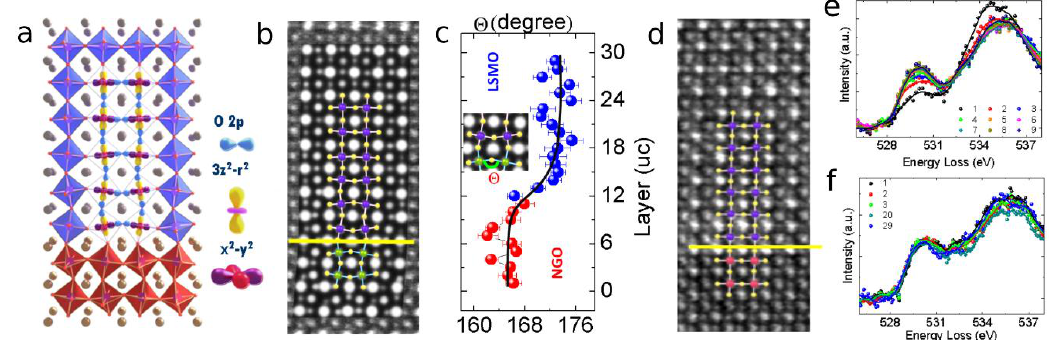
Figure 7. Octahedral tilt and orbital hybridization in a perovskite thin film. ( a ) At the interface between perovskites with different octahedral tilt systems, the oxygen octahedra have to rotate to maintain corner connectivity across the interface; ( b ) inverted-contrast ABF-STEM image showing the octahedral tilt in a LSMO on NGO film. In the inset, the image simulated from the obtained atomic structure (at the centre); ( c ) B-O-B angle between the oxygen atoms and the B cations as a function of the atomic plane; ( d ) inverted ABF-image of a similar film grown on top of a STO buffer layer, displaying no tilt; ( e ) the fine structure of the EELS oxygen peak measured in the buffered film. Each spectrum is measured from a region with a one unit cell thickness. The numbers in the inset indicate the distance of the chosen layer from the interface, expressed in unit cells. There is an obvious dependence of the fine structure from the distance; and ( f ) the fine structure of the EELS oxygen peak measured in the non-buffered film. There does not appear to be any dependence of the shape of the fine structure on the distance from the interface.